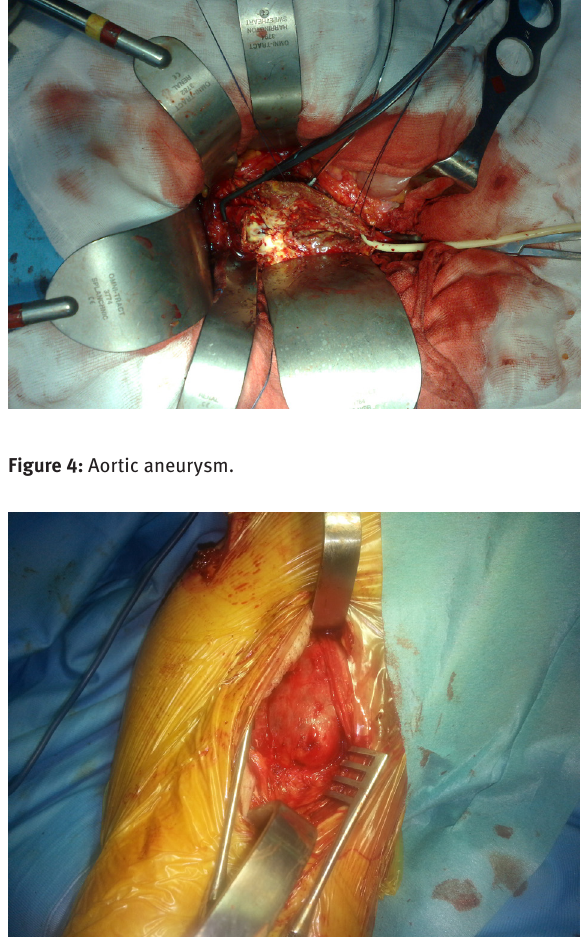
Figure 5: Right axillary artery